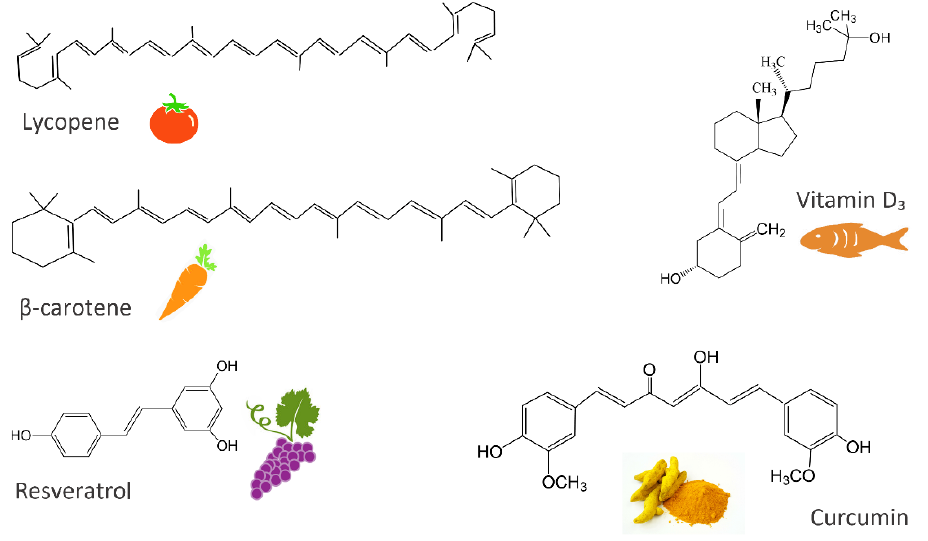
Figure 1. Nutraceuticals.